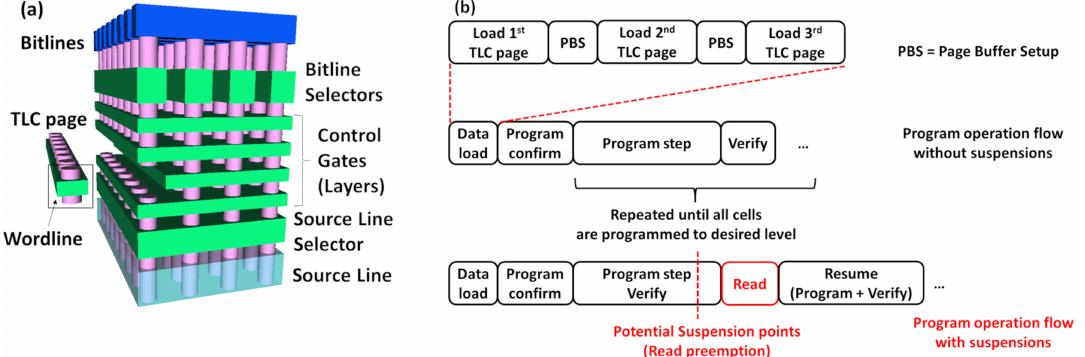
Figure 2. ( a ) The TLC 3D NAND Flash architecture. Reprinted with permission from [29] under Creative Commons License 4.0 (CC-BY). ( b ) An overview of the program operation phase without and with